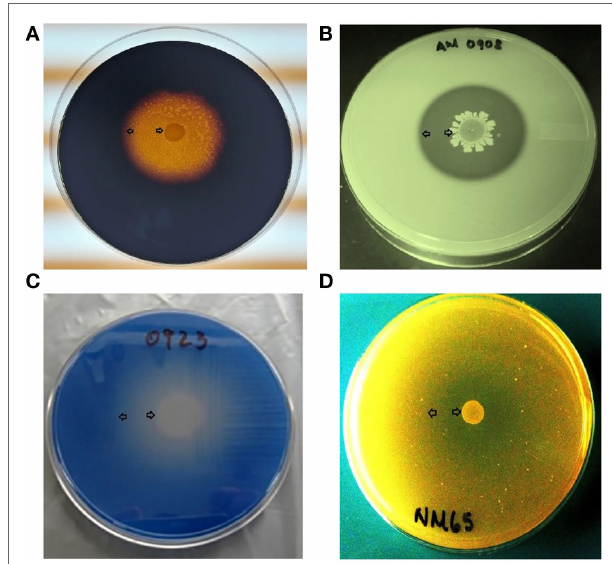
FigUre 1 | representative examples of microbial enzyme activity using a different selective media for each enzyme under evaluation . An area of clearance around a bacterial colony can be observed, representing enzyme production of (a) amylase, (B) protease, (c) lipase, and (D) phytase. All Bacillus spp. strains were screened by triplicate. Arrows indicate the bacterial colony and the outer limit of the zone of clearance.